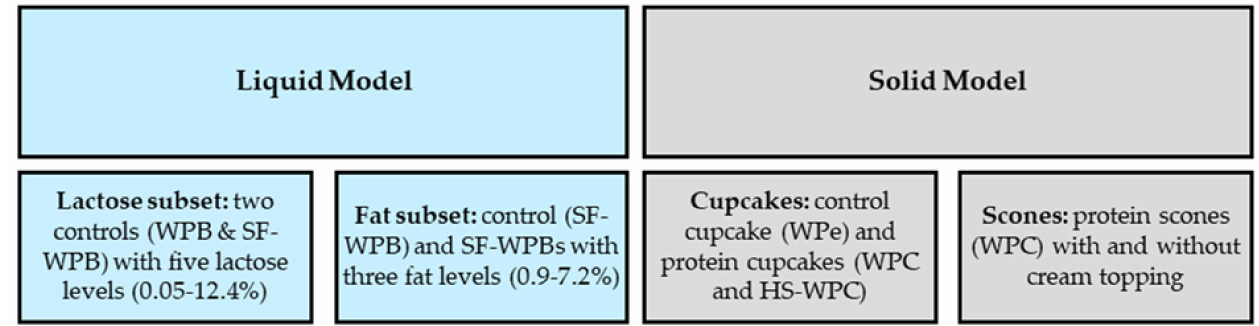
Figure 1. Overview of experiments (WPB: whey protein beverages; SF-WPB: sugar-free whey protein beverage; WPe: whey permeate; WPC: whey protein concentrate; HS-WPC: heat-stable whey protein concentrate). Brackets after each sample name denote specific lactose or fat content expressed as % w / v